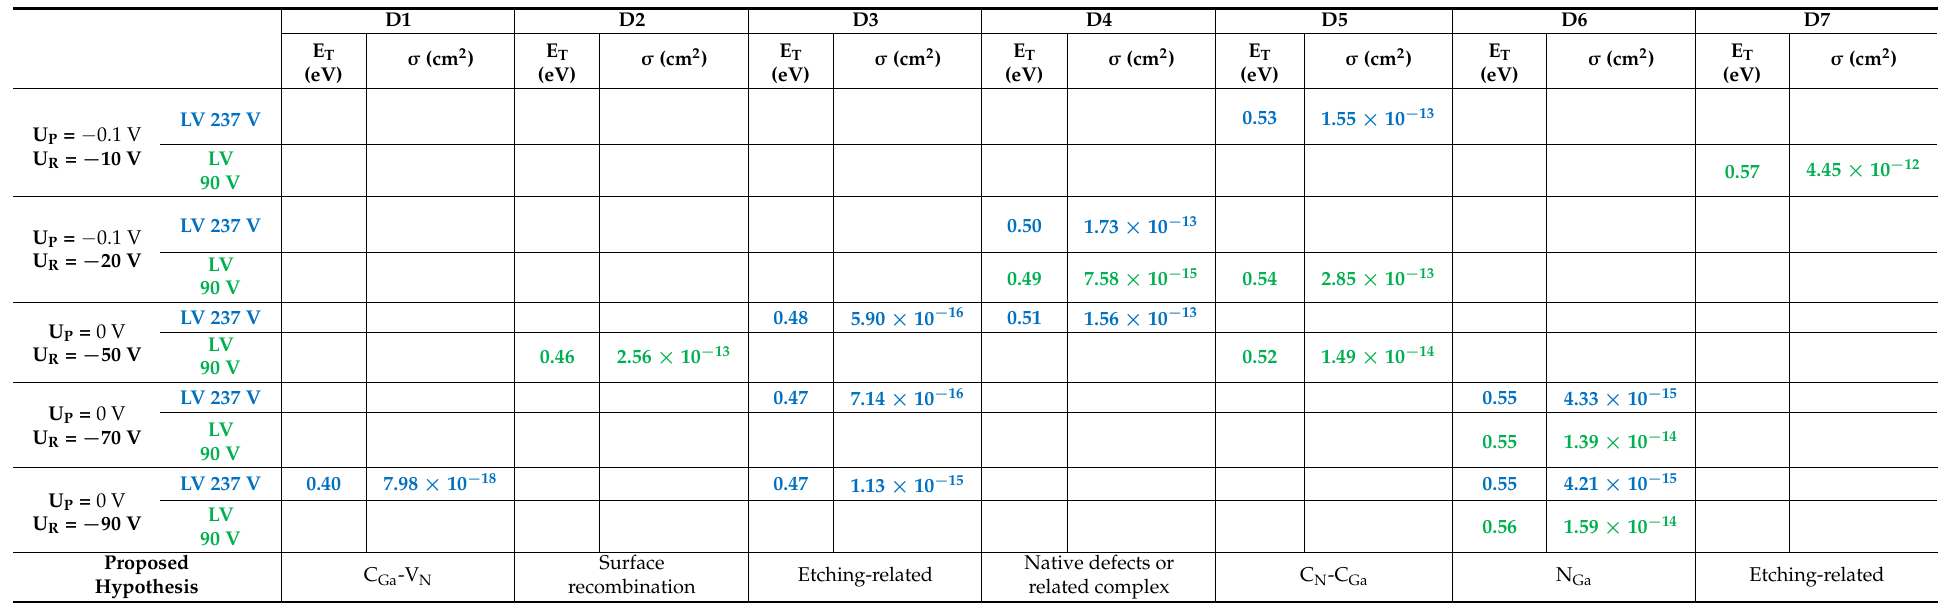
Table 2. Energies and cross-sections extracted from Arrhenius plots for the different samples and at different bias conditions gathered in category D i , with the proposed hypothesis for each